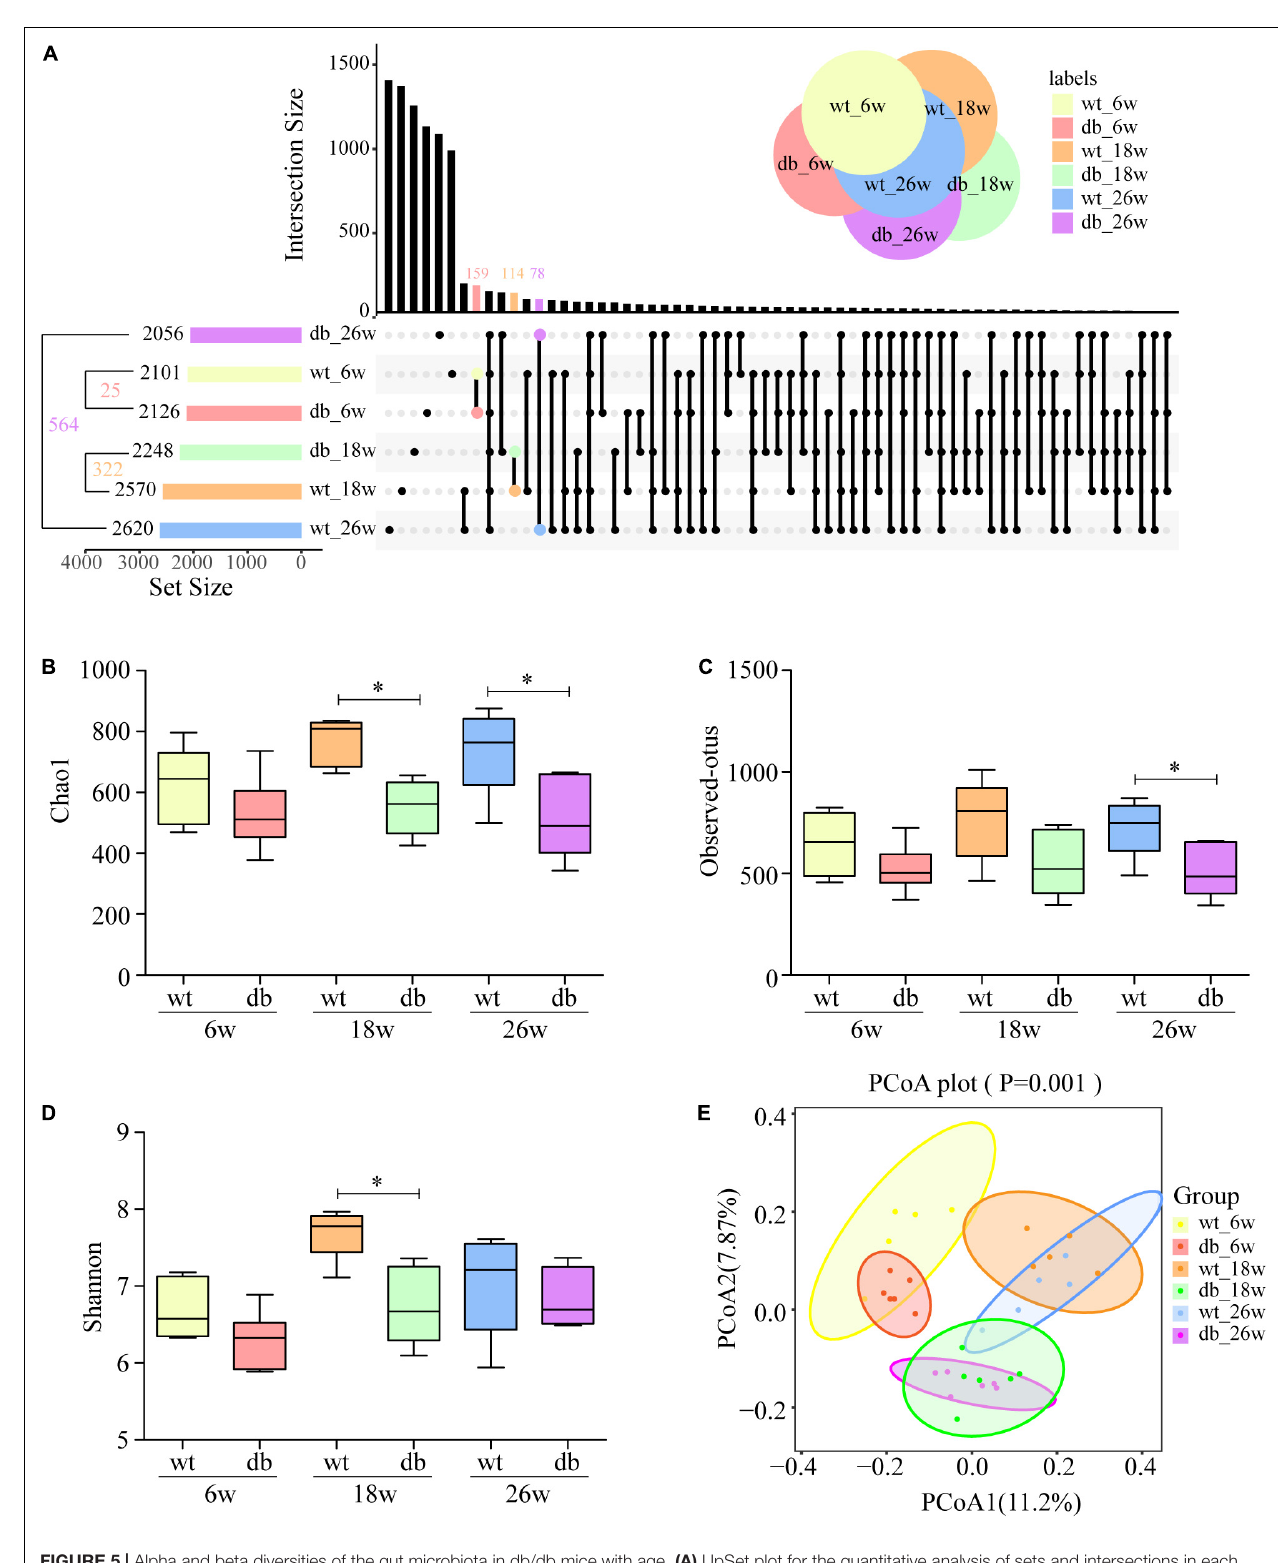
FIGURE 5 | Alpha and beta diversities of the gut microbiota in db/db mice with age. (A) UpSet plot for the quantitative analysis of sets and intersections in each group. (B–D) Variation in alpha diversity (Chao1, Observed-otus, and Shannon) in mice at different ages. (E) PCoA analysis of gut microbiota. ( n = 6 per group); ∗ P <